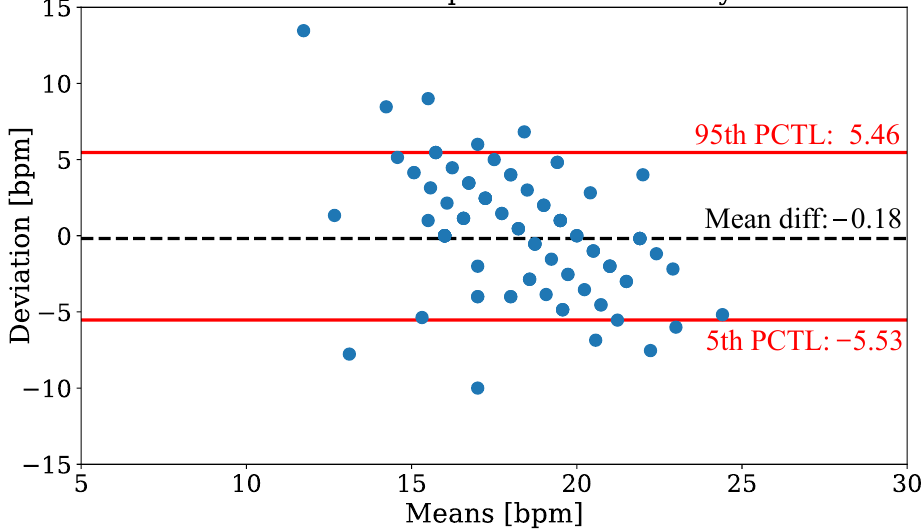
Figure 14. Bland-Altman plot of respiration extraction for the YOLOv4-Tiny detector.